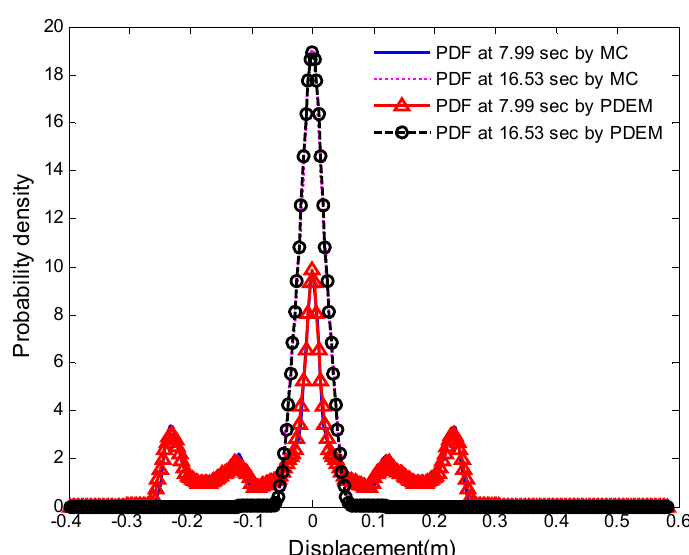
Figure 8. Comparing between probability density evolution method (PDEM) and Monte Carlo of PDFs of displacement at different times.